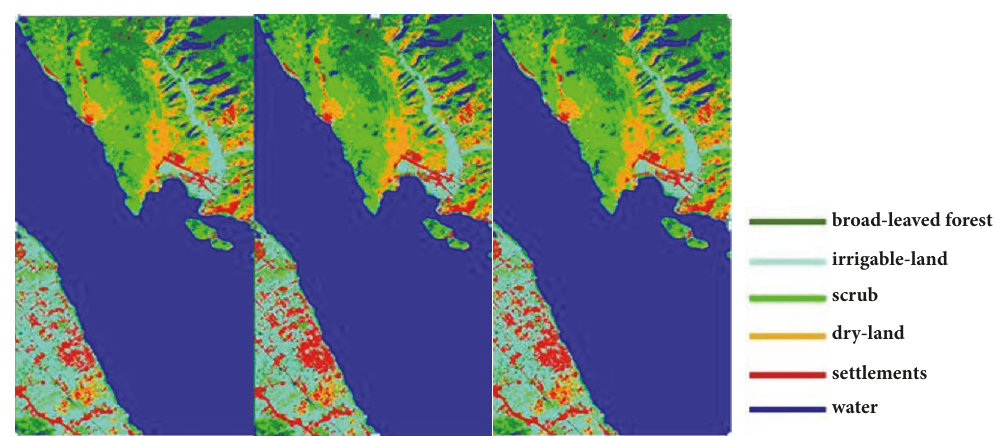
Figure 23: The classification results in the initial 5% label conditions of the algorithm for the Hyperion data.